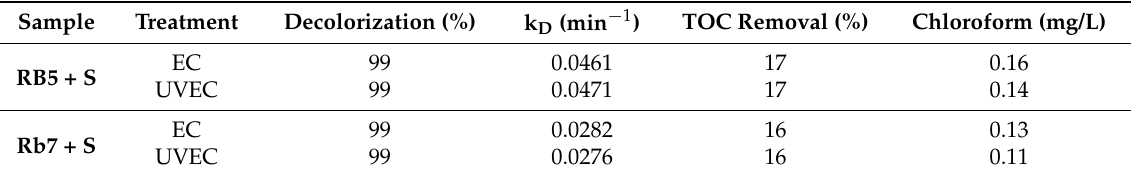
Table 4. Results of EC and UVEC treatments of dyes in the presence of